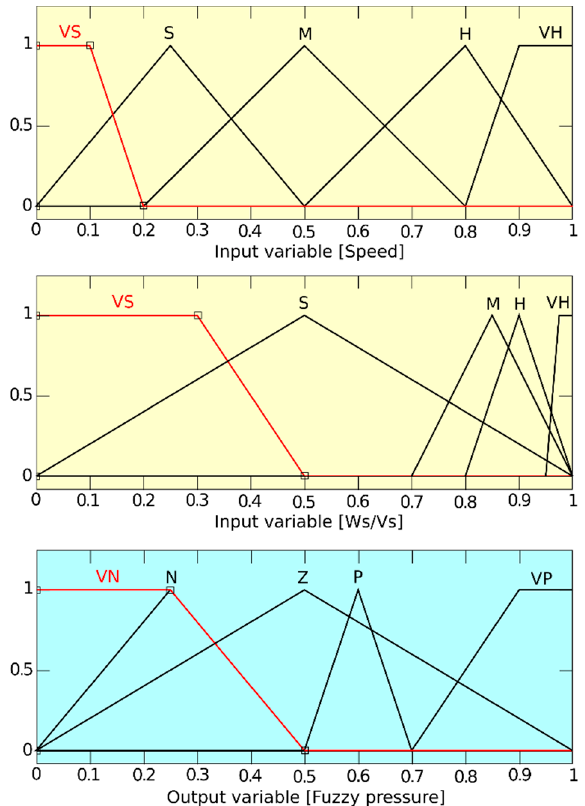
Figure 8. Setting rules of FIS matrix for fuzzy controller.